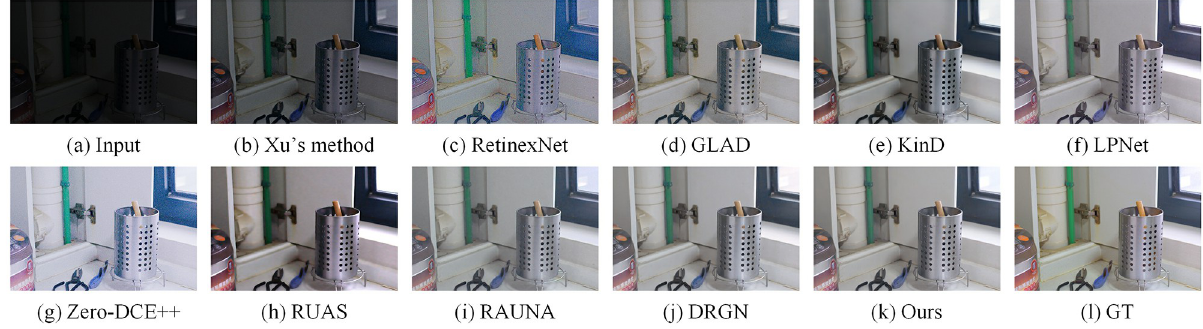
Fig 6. Visual results of different methods on LOL dataset for image number 111. (a) Input. (b) Xu’s method. (c) RetinexNet. (d) GLAD. (e) KinD. (f) LPNet. (g) Zero-DCE++. (h) RUAS. (i) RAUNA. (j) DRGN. (k) Ours. (l) GT.